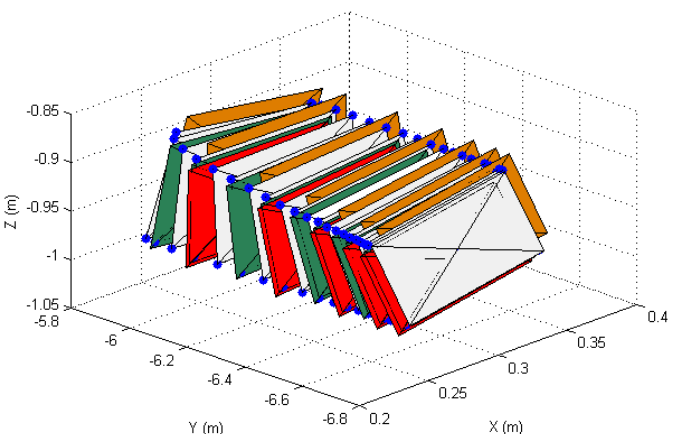
Figure 8. 3D trajectories of the manipulated object obtained during the second set of experiments.